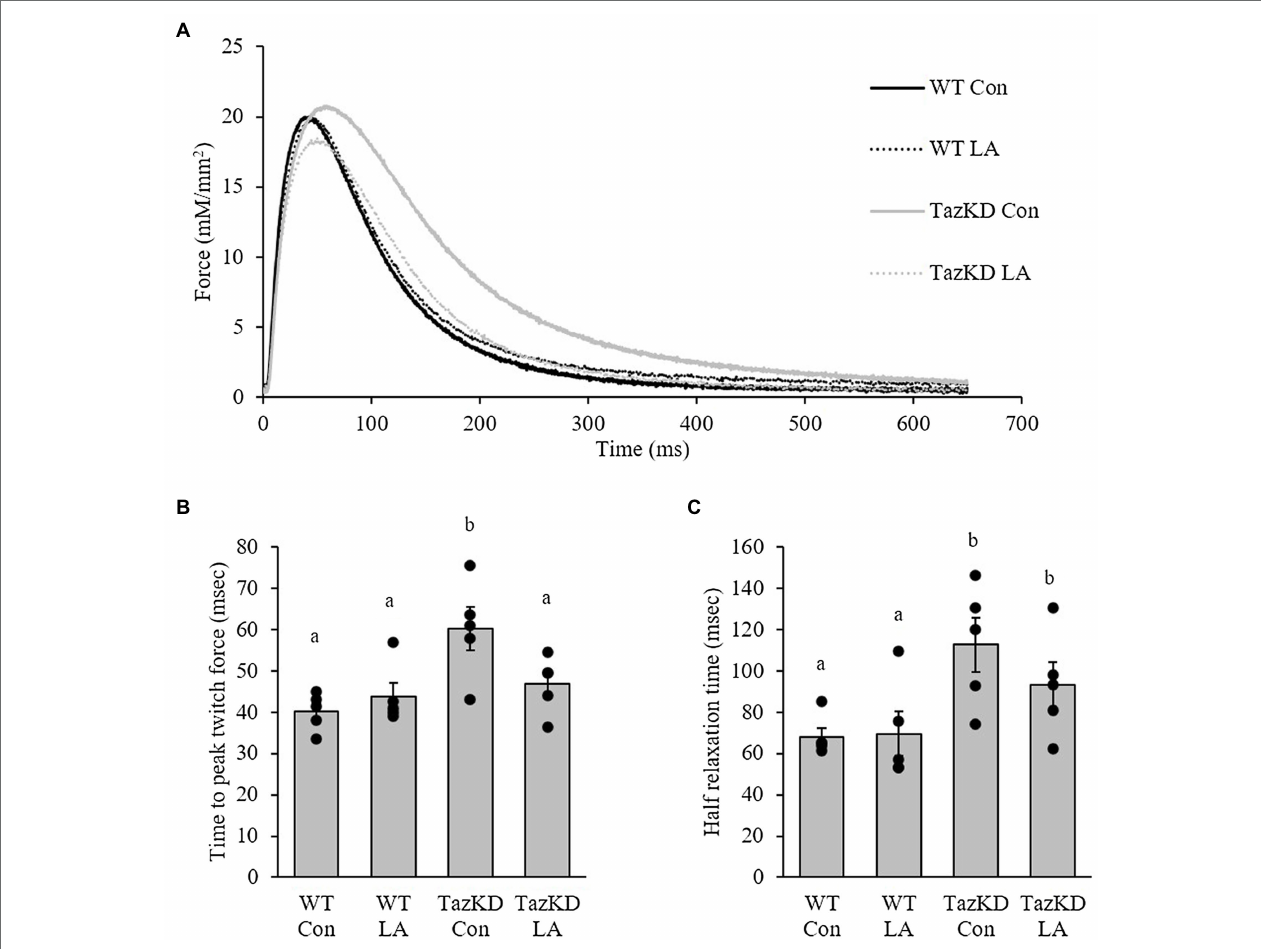
FIGURE 4 | 8 weeks of supplemental linoleic acid diet attenuated, but not significantly, the doxycycline-induced alterations in (A) cardiolipin content but had no influence on (B) cardiolipin linoleic acid content or (C) MLCL:CL ratio in soleus of TazKD male mice compared to their wild-type littermates. Values are means ± SEM, n = 2–6; no statistical difference between values with the same letter ( p < 0.05). CL, cardiolipin; WT, wild type; TazKD, Taz knockdown; Con, chow diet; and LA, linoleic acid-supplemented